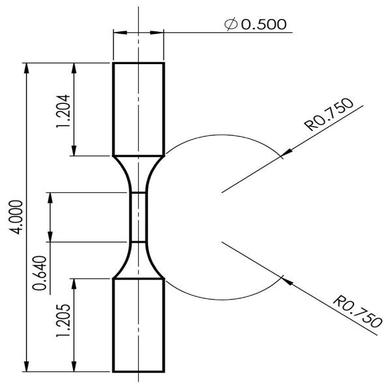
Fatigue specimen dimensions.